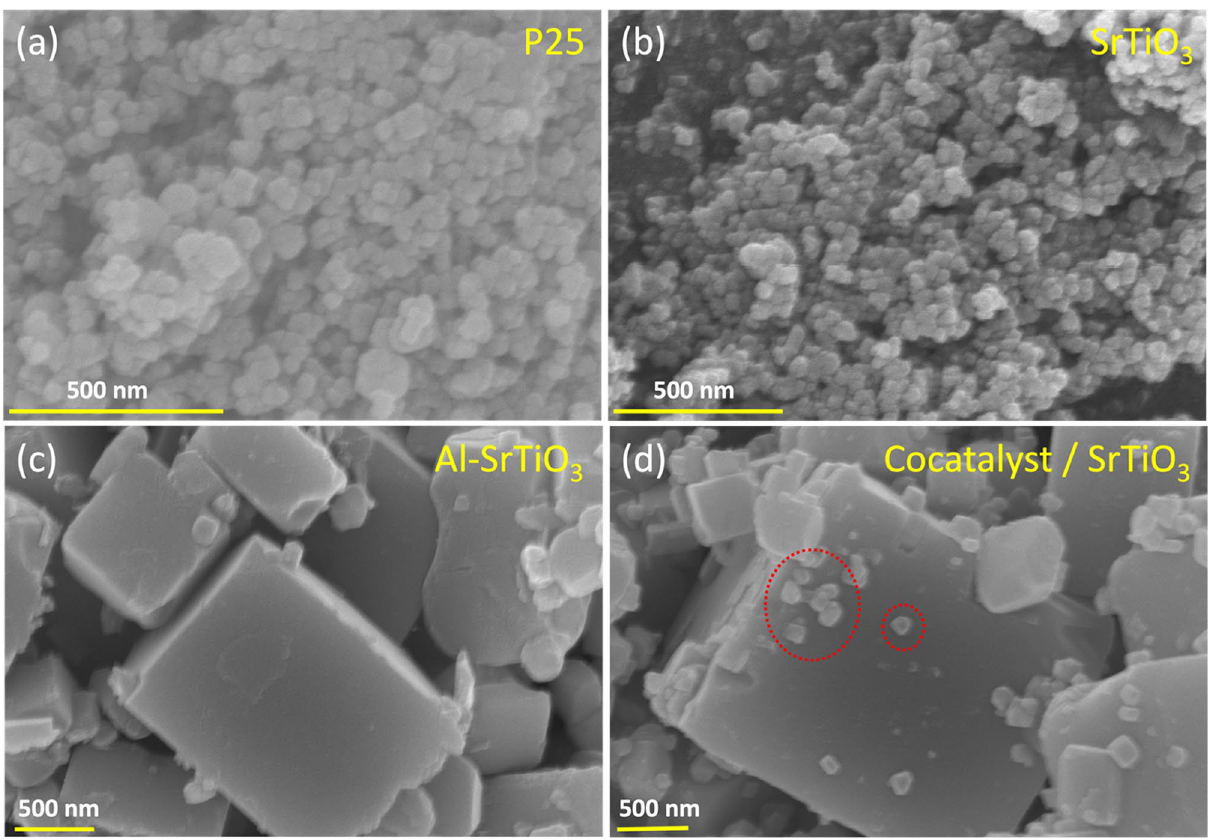
Figure 5. SEM analysis of ( a ) P25, ( b ) SrTiO 3 , ( c ) prepared Al-SrTiO 3 , and ( d ) prepared cocatalyst loaded Al-SrTiO 3 samples.